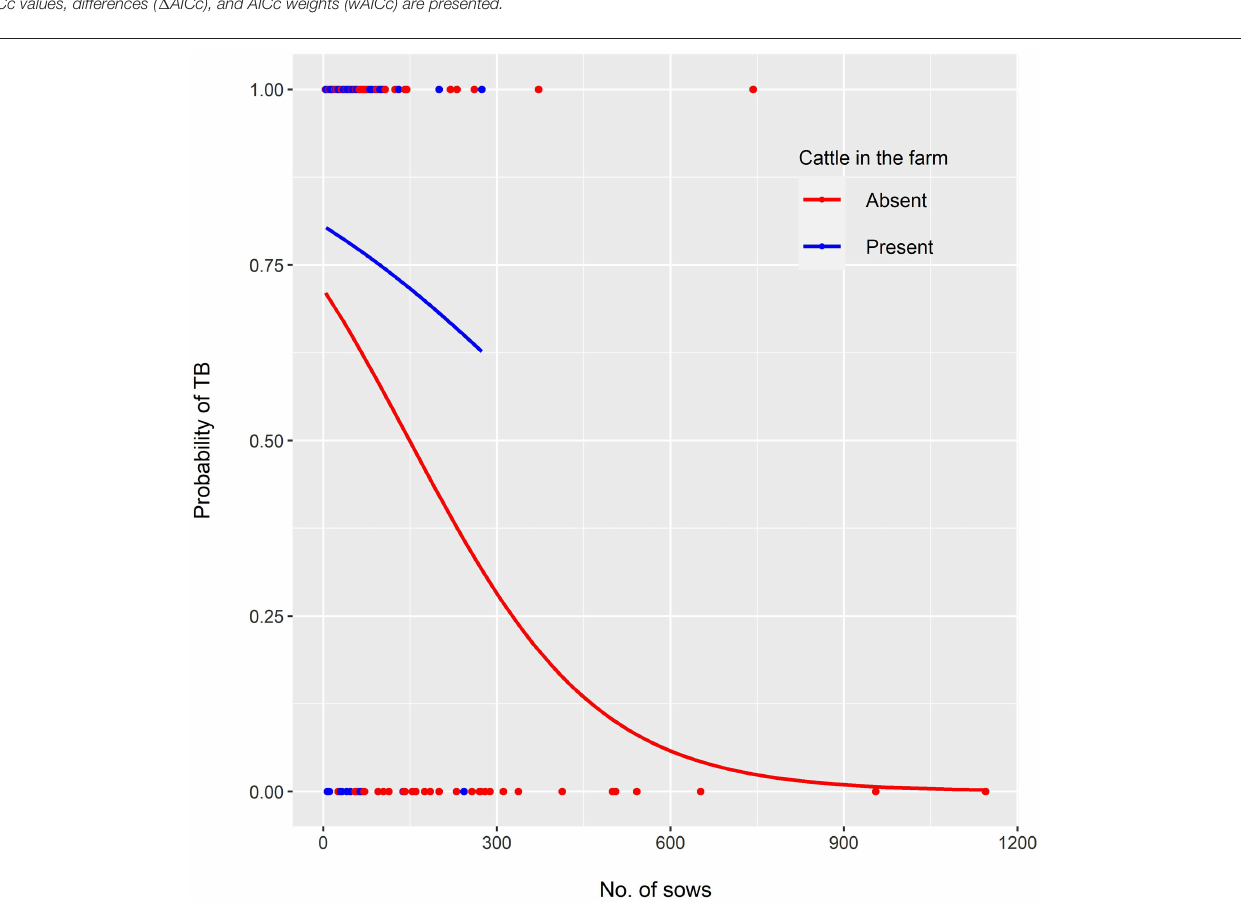
FIGURE 1 | Multivariable logistic model showing the probability of TB confirmation in TBL samples as a function of the number of sows in the farm of origin, when cattle were present or absent (red and blue lines, respectively). Dots along the x axis represent samples with ( y = 1) and without ( y = 0) TB confirmation, in farms where cattle were present (red) or absent